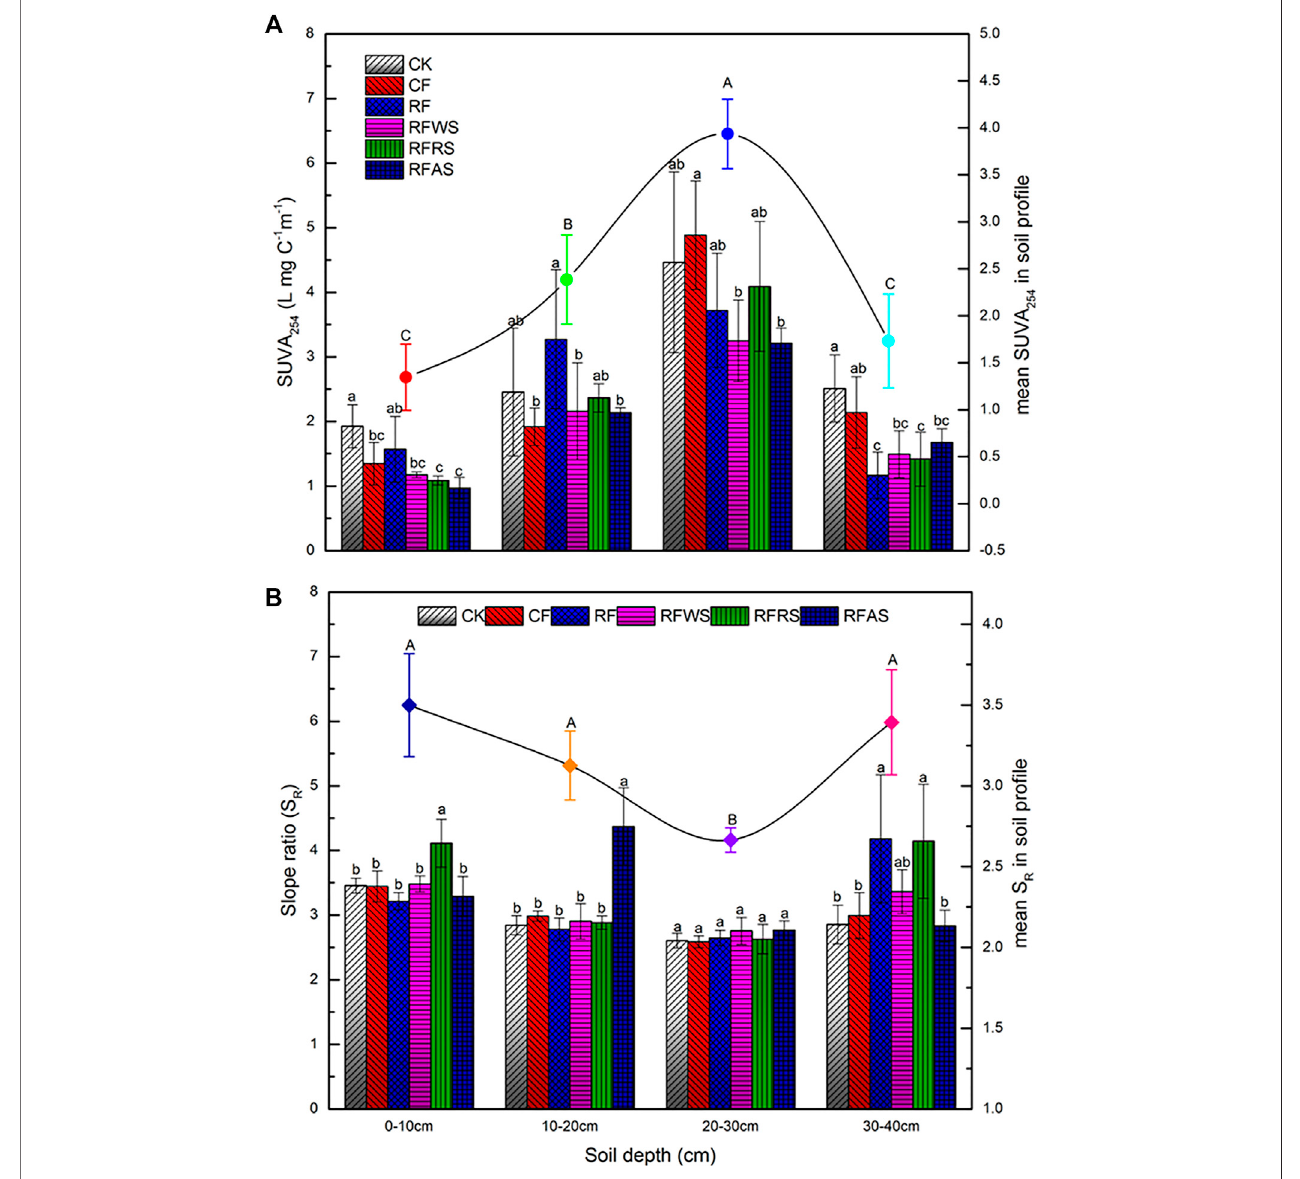
FIGURE3|(A) ChangesofSUVA254valuesfrom soilssampled afterleaching test. (B) ChangesofSRvaluesfromsoilssampledafterleachingtest. Differentcolor barsrepresentdifferenttreatments(treatedin0 – 10 cm)(CK,controltreatmentwithoutorganicmaterialandfertilizer;CF,conventionalfertilizerapplied;RF,reduced20% fertilizer compared with CF; RFWS, wheat straw combined with RF; RFRS, rapeseed shell combined with RF; RFAS, astragalus smicus combined with RF).